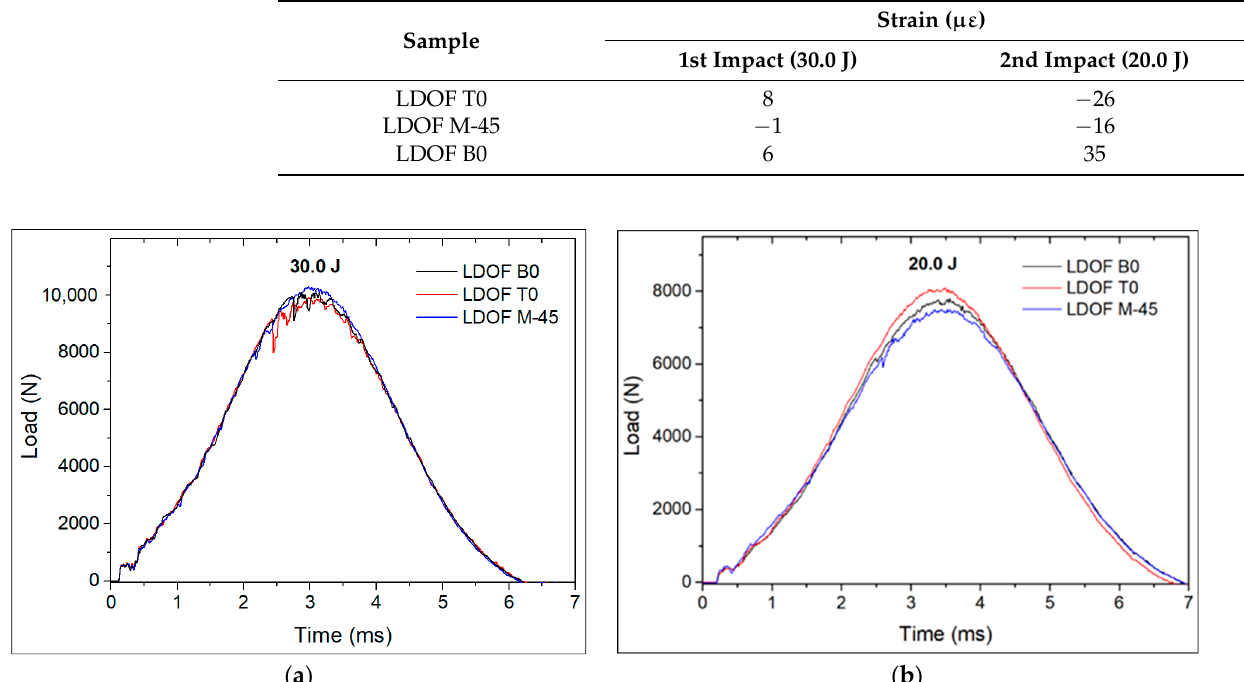
Figure 10. Impactor contact force for LDOF during the ( a ) first impact with 30.0 J and ( b ) second impact with 20.0 J. Table 2. Residual strains measured by embedded LDOF in each of the studied through-thickness locations after the first and second impacts.